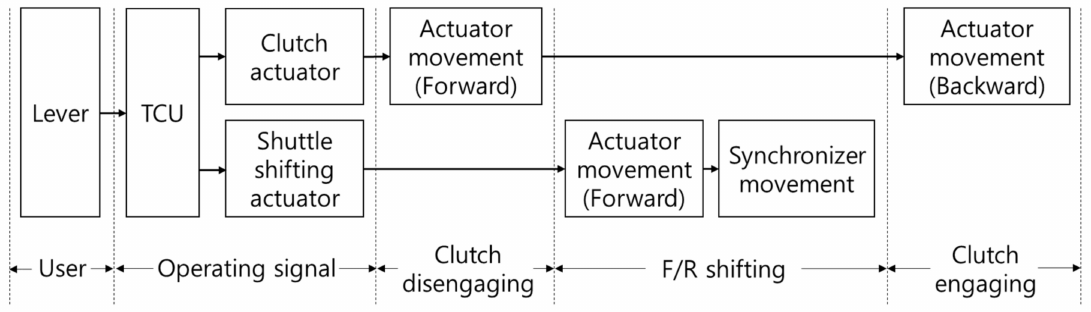
Figure 6. Control procedure of the AMT system in case of neutral to